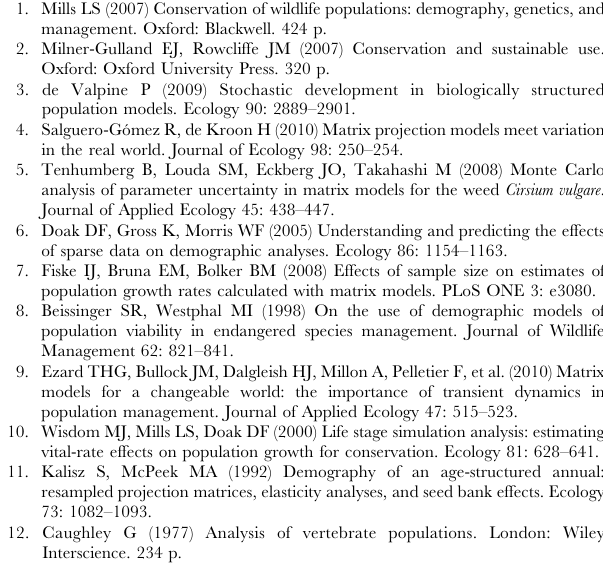
Table S1 Results of a literature review showing the number of studies that failed to include an accompanying measure of uncertainty of the estimated population growth rate. We conducted a Web of Science (http://apps.isiknowledge.com) search from January 2008 to May 2010 using the search terms ‘population growth’, ‘matrix model’, and ‘demography’. We separated the results by taxa, and further distinguished those that used previously published data to estimate matrix transition elements. We also recorded the impact factor of the journal for each result. The results are presented as a percentage of the total studies, the number of studies using published demographic data, and those published in a journal with a 5-year impact factor of four or higher (based on Web of Science, Journal Citation